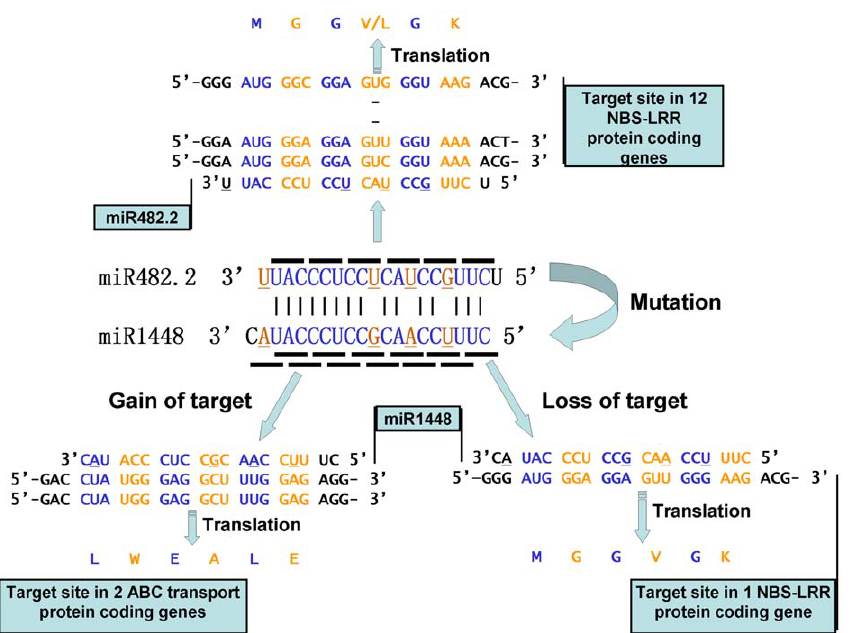
Figure 6. Patterns of gain and loss of target genes in miR1448 miRNAs. For the four nucleotide mutations that occurred in the mature sequence of miR1448 when compared to miR482.2, poplar miR1448 lost the control of most of the target genes (miR482.2 targeted 12 NBS-LRR protein-coding genes while miR1448 only targeted 1 NBS-LRR gene). On the other hand, through a frameshift-targeted mechanism, miR1448 captured two ABC transport protein-coding genes as target genes. The underlined nucleotide site in the miRNAs represents the substitution sites when miR1448 is compared to miR482.2.